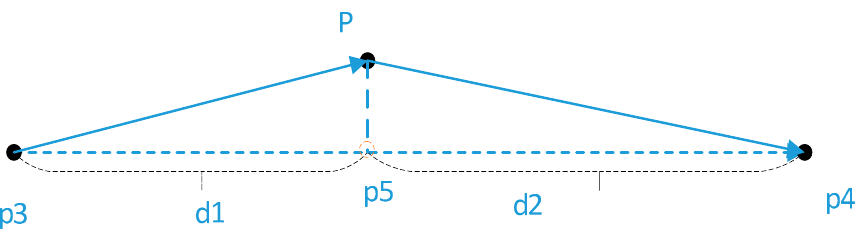
Figure 4. Schematic for splitting a candidate edge into two more detailed edges.